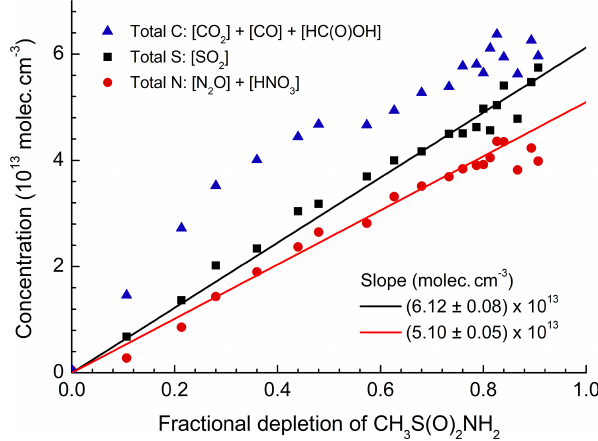
Figure 5. Summed concentration of carbon-containing products (CO 2 , CO, and HC ( O ) OH), sulfur-containing products (SO 2 ), and nitrogen-containing products (N 2 O and HNO 3 ) plotted versus the relative depletion of MSAM. The slope gives the initial concentra- tion of MSAM assuming stoichiometric conversion to the products